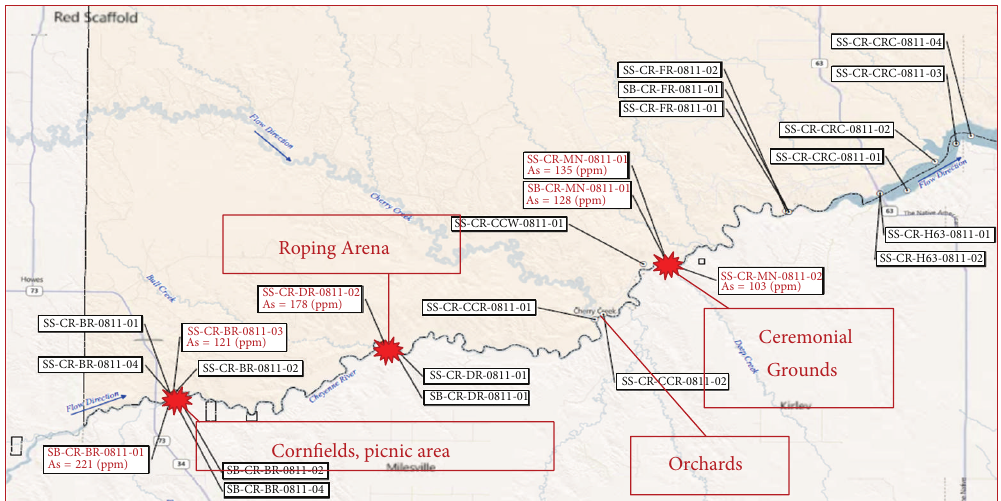
Figure 2: Map of arsenic sampling conducted by USEPA and CRST DENR. Concentrations of arsenic in sediment exceeding 100ppm are marked with a burst pattern. Exposure-relevant sites are labeled with activities frequently conducted in those